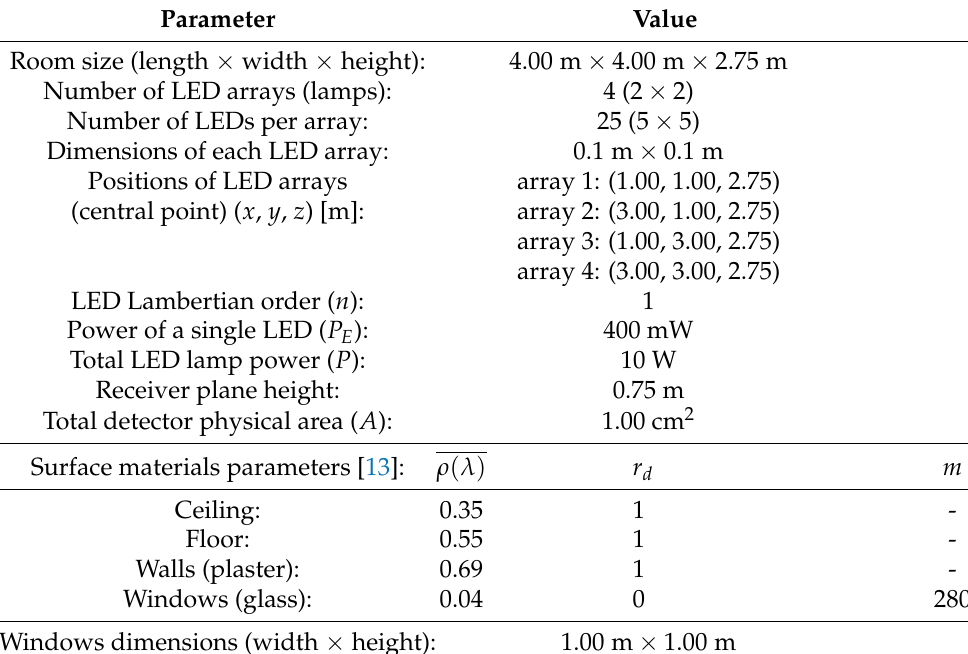
Table 1. Parameters of VLC Simulation Scenario.